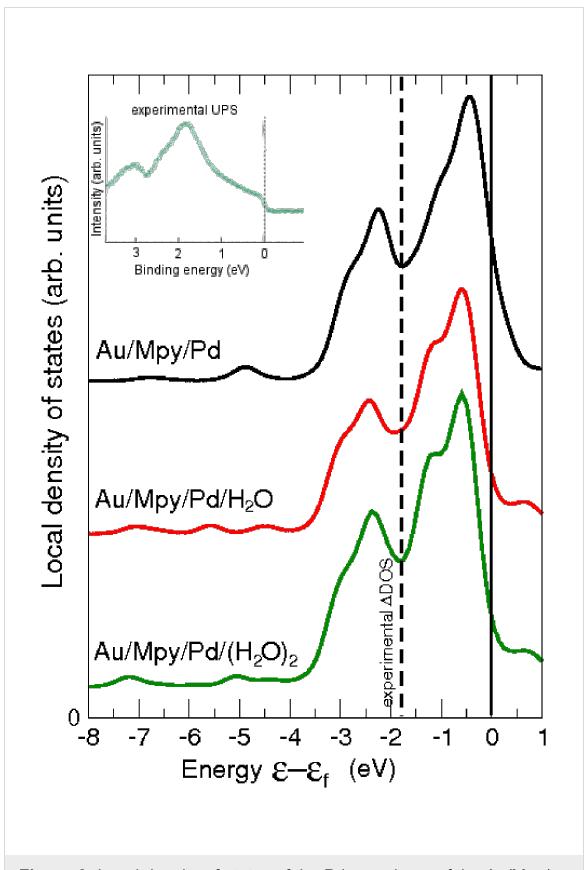
Figure 6: Local density of states of the Pd monolayer of the Au/Mpy/ Pd system with and without water. Au/Mpy/Pd denotes bare the system without water, Au/Mpy/Pd/H 2 O denotes an isolated H 2 O mole- cule on the surface ( = 1/3 ML), and Au/Mpy/Pd/(H 2 O) 2 denotes a water hexagonal bilayer attached on the surface ( = 2/3 ML). In the inset, the experimental UPS spectrum of the corresponding system is included (adopted from